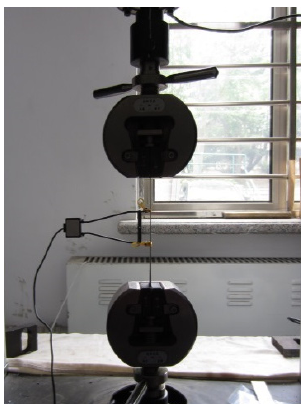
Figure 2. Tensile test of BFRP laminates.